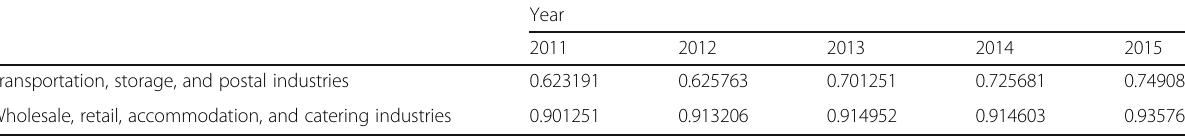
Table 2 Stripping coefficient of tourism